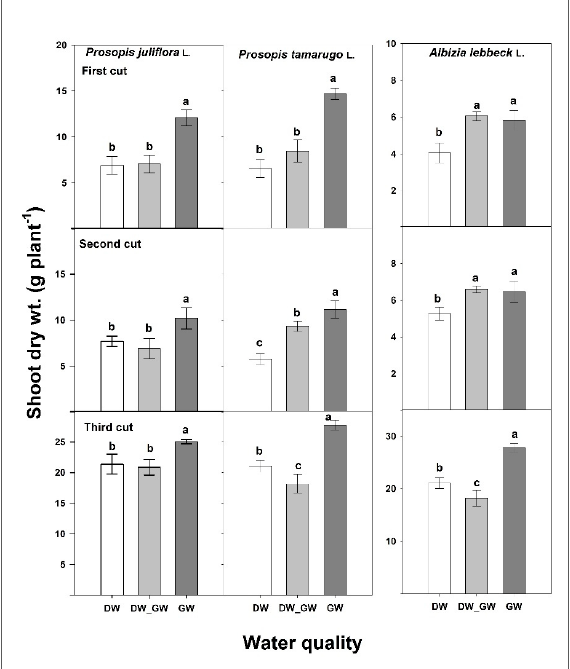
Figure 3. Fresh yield of different multipurpose tree species ( Prosopis juliflora L., P. tamarugo L., and Albizia lebbeck L.) grown under different water quality treatment; distilled water (DW), distilled + greywater (DW_GW), and greywater (GW). Bars represent mean ± SE. Different letters indicate a significant difference between treatments ( p ≤ 0.05). Untreated greywater normally contains higher nutrients and bacterial populations than tap water, but the treatment process reduces the concentration of most unwanted greywater parameters and brings them into irrigation standards [25]. A recent review on quality and quantity of greywater reuse showed large variations in greywater quality and quantity associated with time and source, and the filtration treatment [33]. Interestingly, that review concluded that heavy metals and organic micro-pollutants in treated grey- water rarely pose a threat to human health if recycled properly. Greywater reuse, after treatment, sustains water resources by conserving irrigation water and protects the aquatic ecosystem (freshwater ecosystem) from the adverse effect of wastewater [25]. De- spite these high counts of fecal coliforms (4 × 10 5 /100 mL) and fecal streptococci (2000/100 mL) in greywater, no significant difference in contamination levels was found between crops (carrots and lettuce) irrigated (eight weeks) with greywater and tap water [34]. Shi et al. [35] assessed the microbial risk of using two greywater reuse scenarios, toilet flush- ing, and food-crop irrigation. They found that treated greywater from the bathroom, laun- dry, and kitchen could be safely used for toilet flushing. The median range of annual in- fection risk when using treated greywater was estimated at about 8.8 × 10 − 15 –8.3 × 10 − 11 per-person-per-year (pppy), which were within the acceptable levels of US Environmental Protection Agency (US EPA) annual infection risk ( ≤ 10 − 4 pppy). For food-crop uses, the estimated annual infection risk greywater (bathroom and laundry) reuse was below the